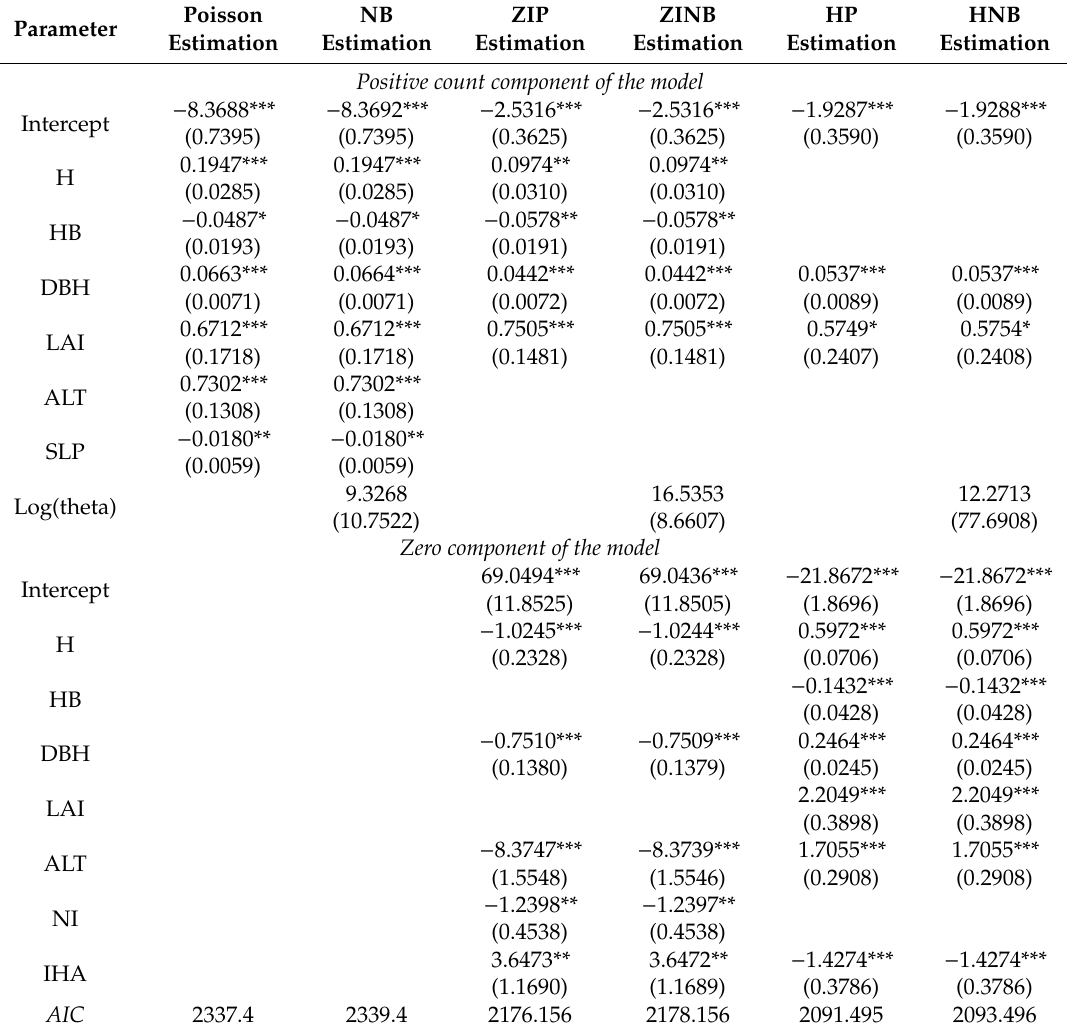
Table 2. Parameter estimates and fit statistics of Poisson, Negative binomial (NB), Zero-inflated Poisson (ZIP), Zero-inflated negative binomial (ZINB), Hurdle-Poisson (HP), and Hurdle negative binomial (HNB) models for species richness of epiphytic